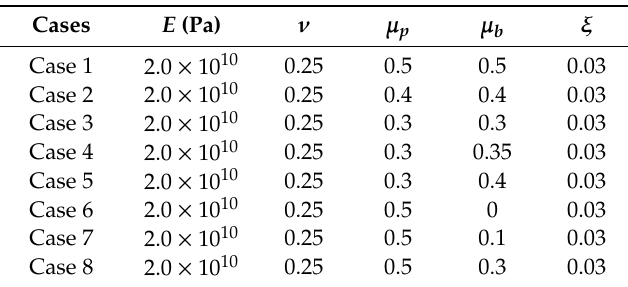
Table 1. Microscopic of the particle